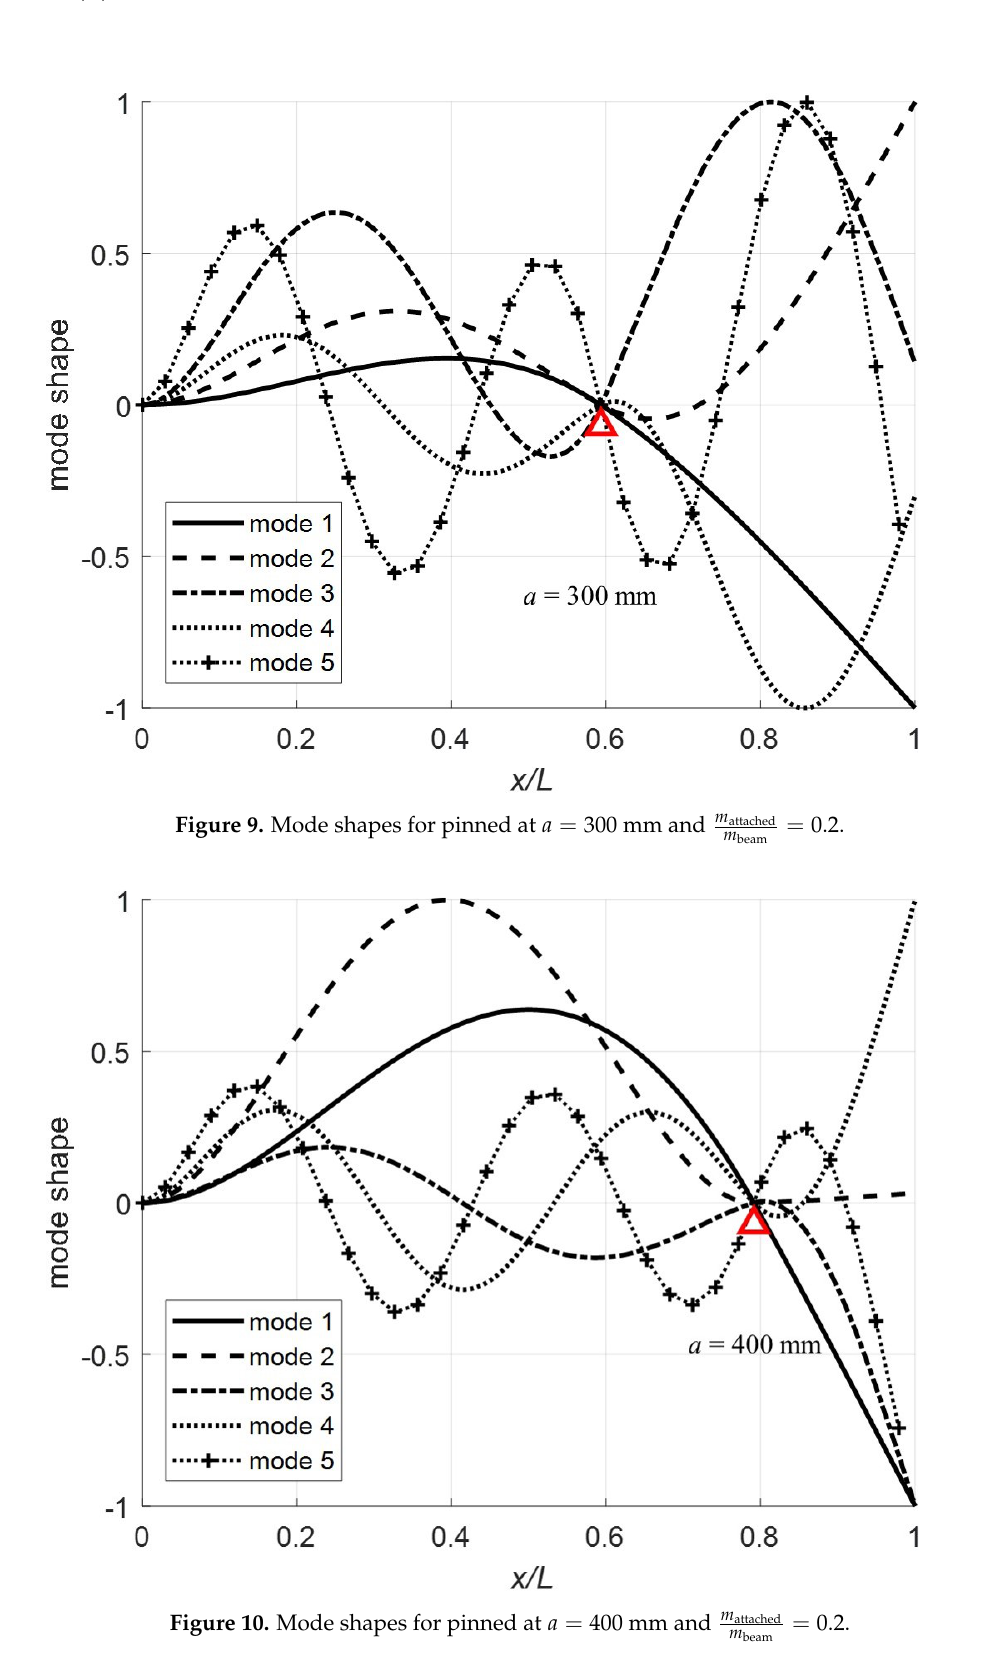
Figure 10. Mode shapes for pinned at a = 400 mm and m attached